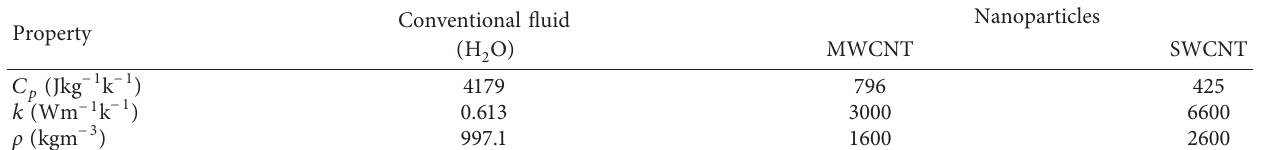
( Le ) , moving wedge parameter ( c ) , temperature relative